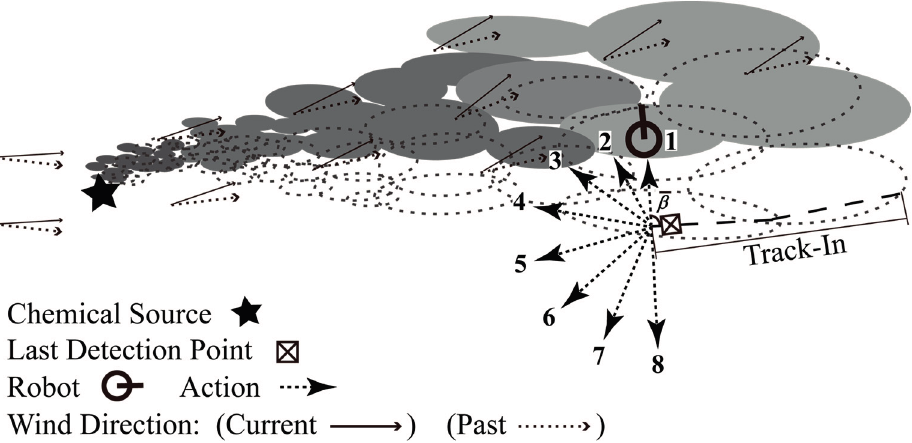
Figure 3. Discretizing the continuous action space to a set of eight